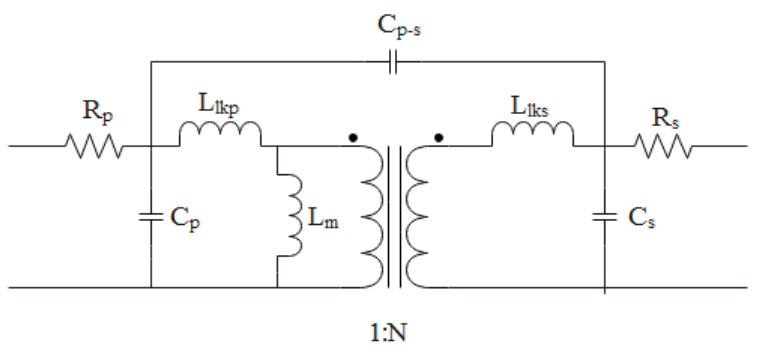
Figure 5. High ‐ frequency transformer including parasitic elements. Figure 5. High-frequency transformer including parasitic